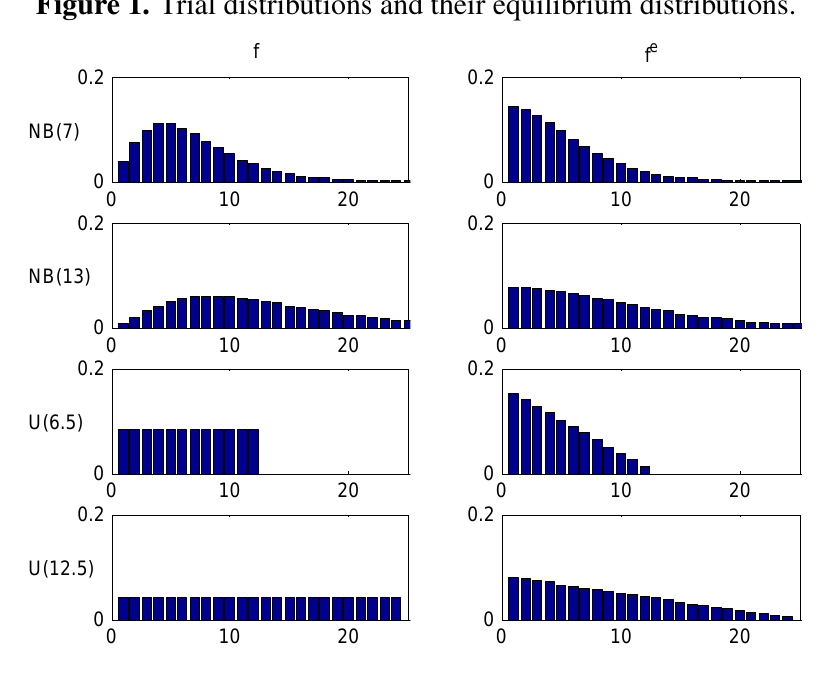
Figure 1. Trial distributions and their equilibrium